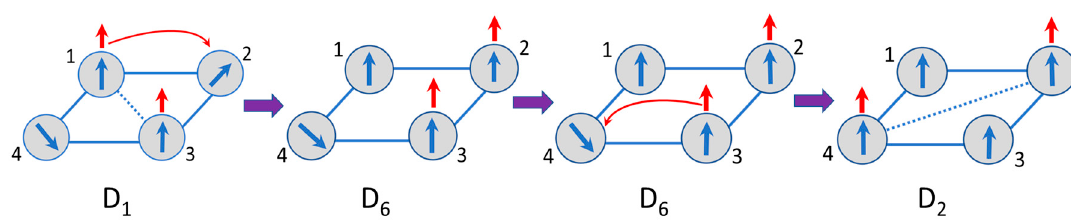
Figure 5. Visual representation of the sequential 1 → 2, 3 → 4 double electron transfer D 1 → D 2 which acts within the basis spin-functions belonging to the two antipodal localization of the electronic pair in MV tetramer of (cid:1856) (cid:2869)(cid:3041)(cid:2878)(cid:2869) − (cid:1856) (cid:2870)(cid:3041)(cid:2878)(cid:2869) − (cid:1856) (cid:2871)(cid:3041) − (cid:1856) (cid:2872)(cid:3041) type. Spin polarization effect is also schematically shown. Table 1. Spin levels E ( S ) / τ belonging to the antipodal charge configuration in the strong U limit. The numbers of the levels having the same spin and energy are indicated in parentheses.